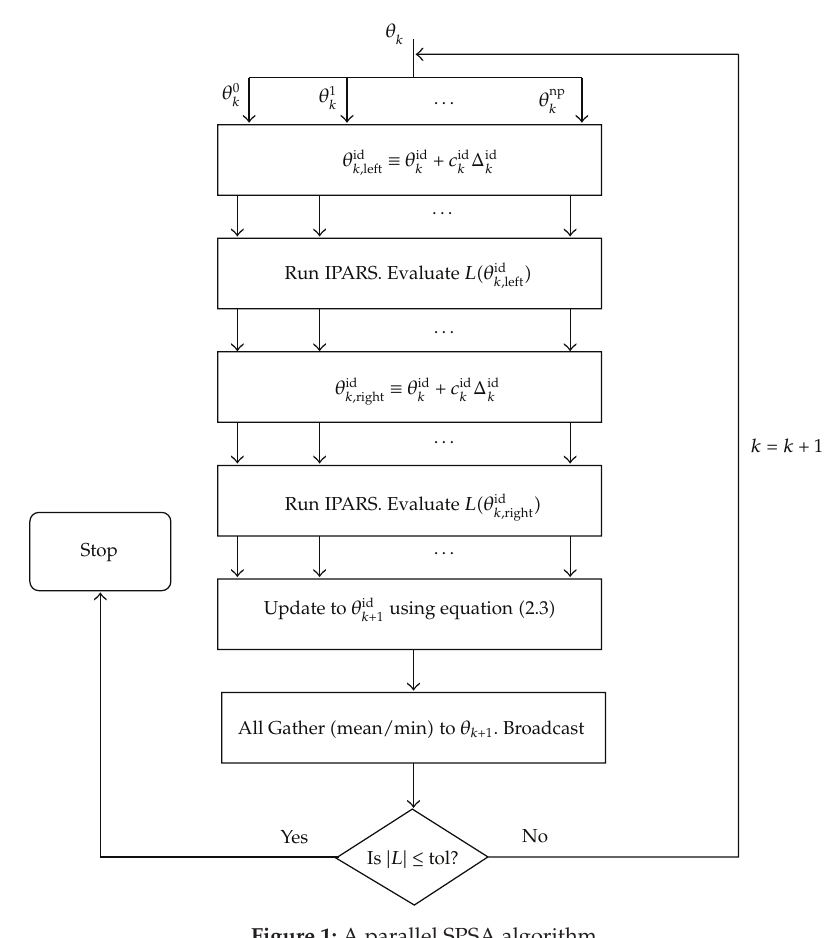
Figure 1: A parallel SPSA